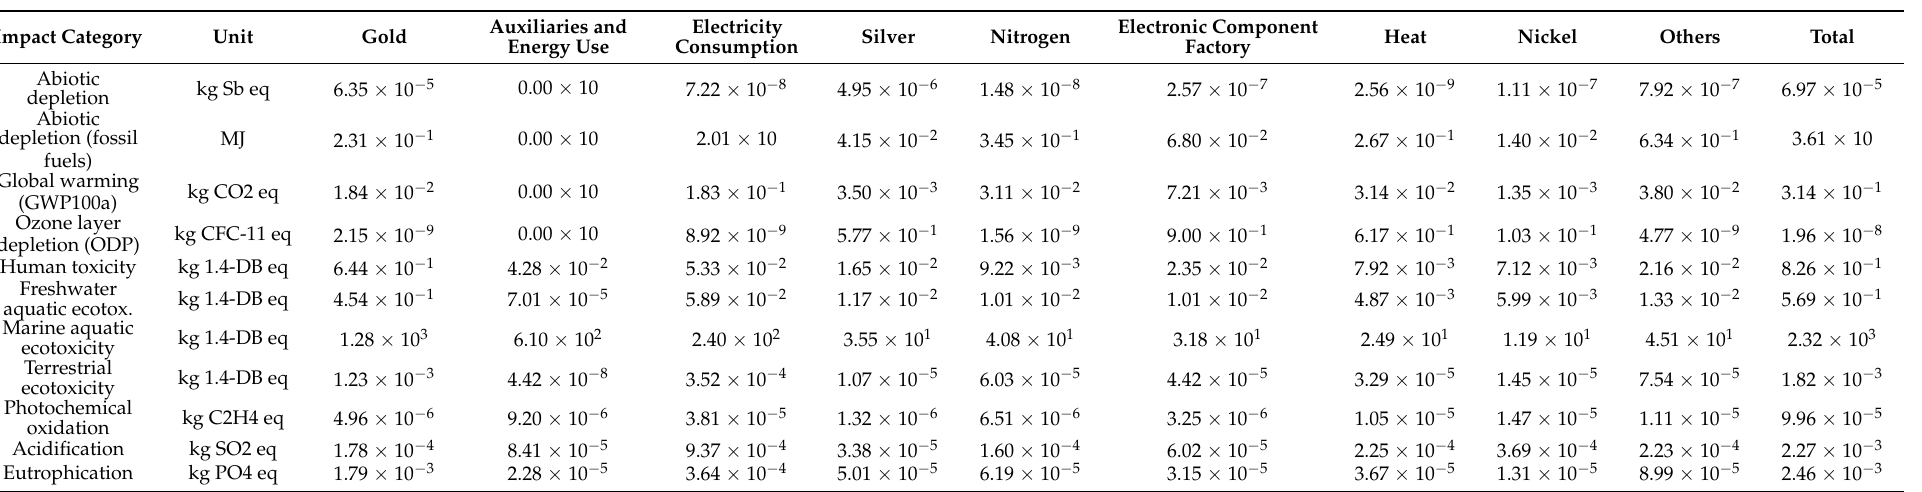
Table 8. Detailed study of the environmental impact of diode PLVA650A (impacts for 1 g of diode).